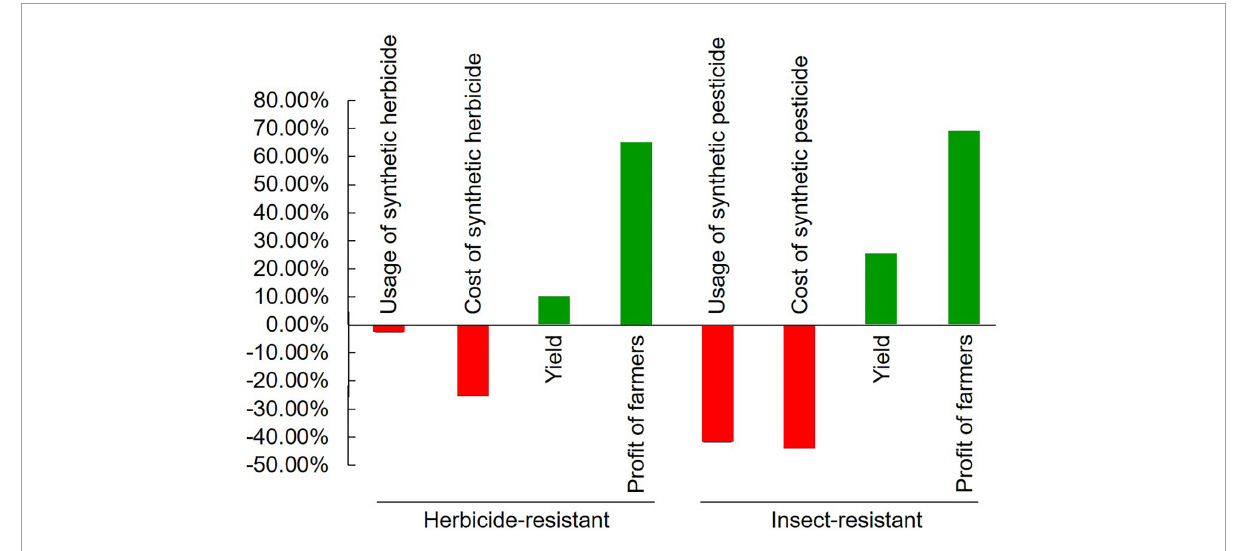
FIGURE2 Benefits of transgenic herbicide- and insect-resistant crops.